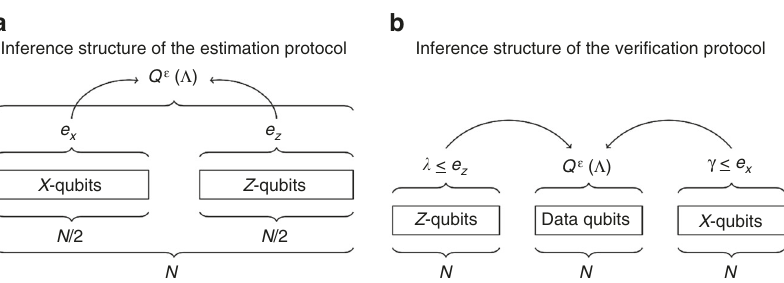
Fig. 2 Comparison of the inference structures of the two protocols. a In the estimation protocol, all qubits are test qubits, and the goal is to estimate the capacity for the channel on all qubits. b In the veri fi cation protocol, one third of the qubits are data qubits that are left untouched. The remaining 2 N qubits are test qubits, whose error rates allow to bound the capacity of the channel on the N data qubits